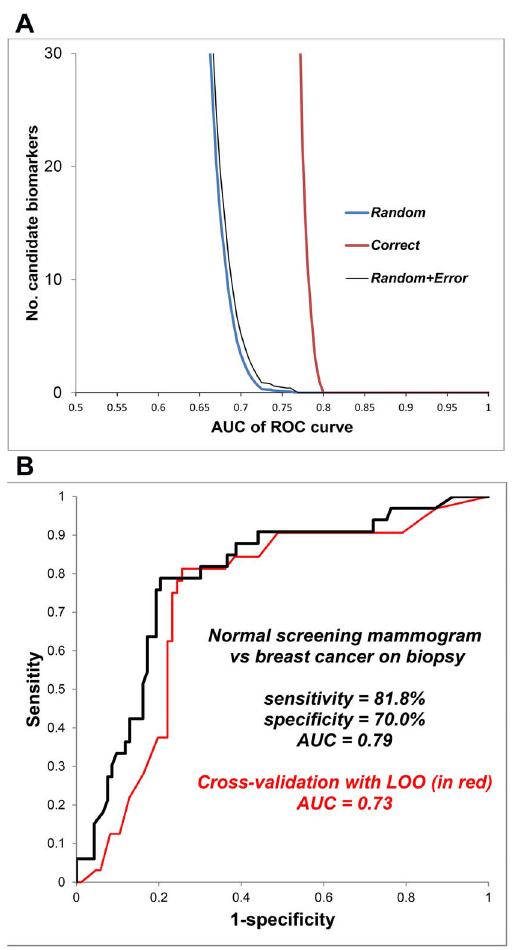
Figure 1. Breath test outcome in healthy women (normal screening mammogram) versus women with breast biopsy positive for cancer. Identification of breath biomarkers (upper panel): A list of candidate breath biomarkers of disease was